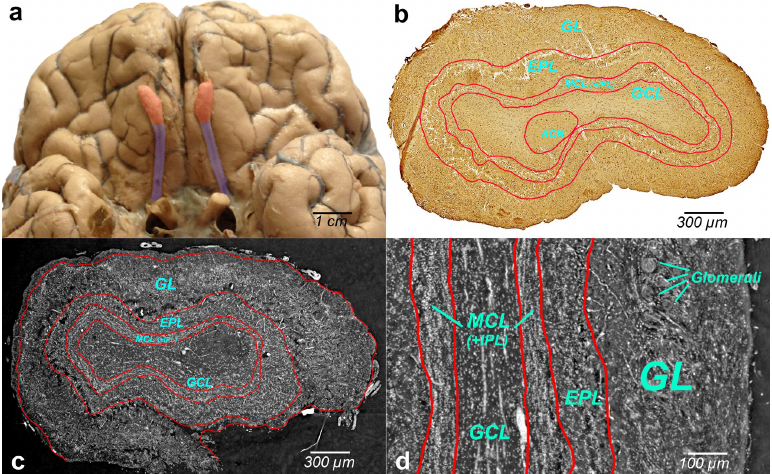
Figure 2. ( a ) Photographic image of the human brain with two olfactory bulbs (bilateral reddish- colored structures) and olfactory tract (violet-colored bilateral bundle of nerve fibers); ( b ) immuno- histochemical staining with antibodies to neuron-specific β -III-tubulin in human OB section (axial plane) with multi-layered cellular architecture: glomerular layer (GL), external plexiform layer (EPL), mitral cell layer & internal plexiform layer (MCL (+IPL)), granule cell layer (GL), anterior olfactory nucleus (AON); ( c , d ) XPCT grayscale image of the OB slice, ( c ) axial plane, ( d ) sagittal